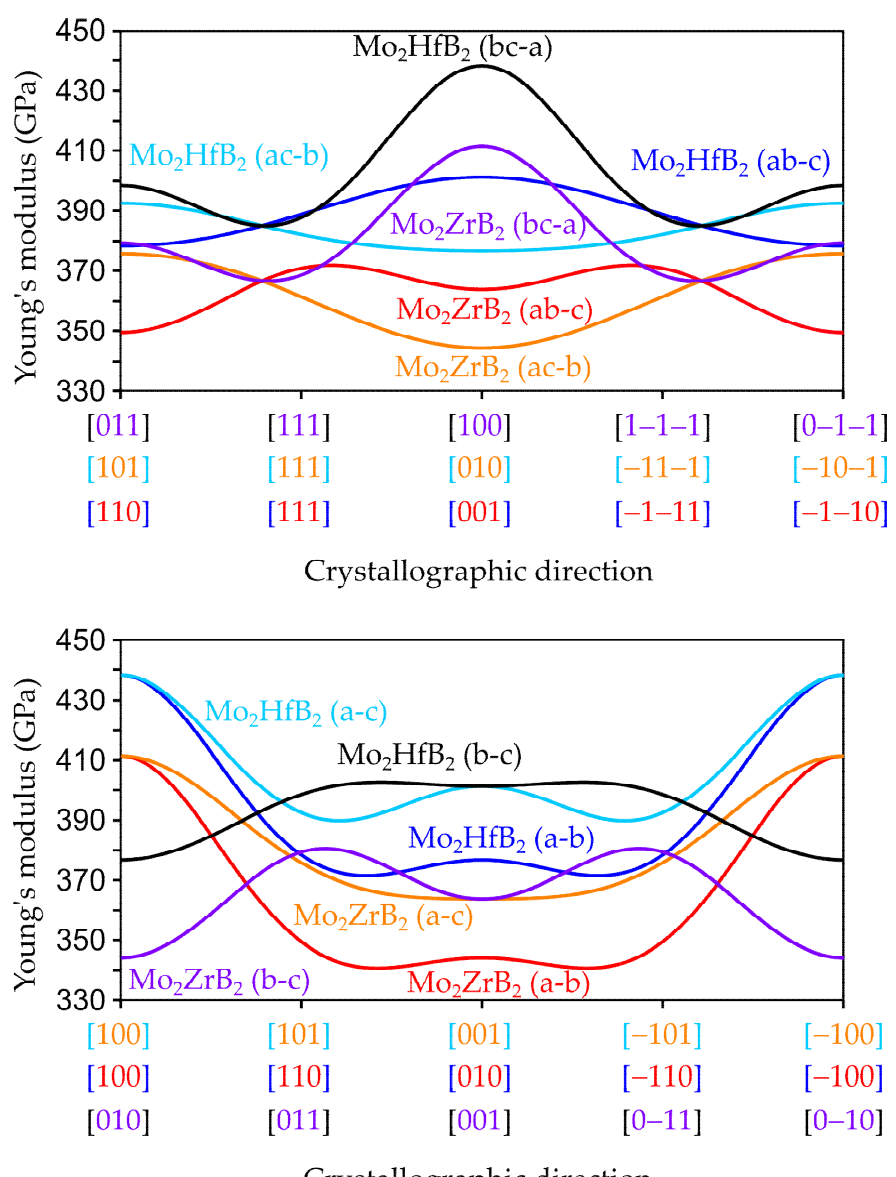
Figure 6. Anisotropic Young’s modulus in the a - b , a - c and b - c -plane ( lower part ) and the ab - c , ac - b and bc - a -plane ( upper part ) of Mo 2 ZrB 2 (red, orange and purple) and Mo 2 HfB 2 (blue, cyan and black), respectively, both with the AlMn 2 B 2 -type structure.